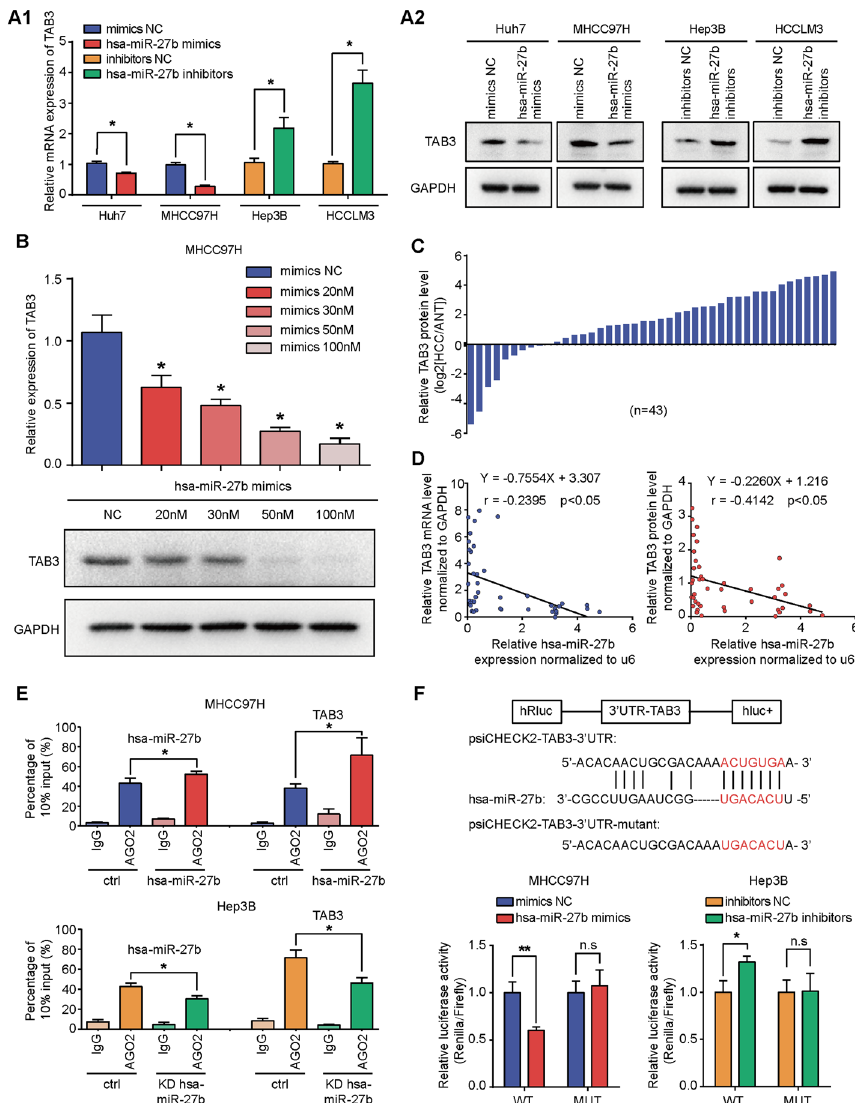
Fig. 4 TAB3 is the downstream target of hsa-miR-27b . A1 , A2 qRT-PCR ( A1 ) and western blot ( A2 ) analysis of TAB3 mRNA and protein levels after overexpression or knockdown of hsa-miR-27b in HCC cells. Data were normalized with GAPDH and are shown as the fold change relative to the control cells. GAPDH was used as a loading control for western blot analysis ( n 3 for qRT-PCR, Mann–Whitney test). B MHCC97H cells were = transfected with hsa-miR-27b mimics at the indicated concentrations. qRT-PCR analysis of TAB3 mRNA (top) and western blot analysis of TAB3 protein levels (bottom) were performed. Data were normalized to GAPDH and are shown as fold change compared with the cells treated with an NC for qRT-PCR ( n 3, one-way = ANOVA). GAPDH was used as a loading control for western blot analysis. C Relative TAB3 expression in HCC tissues ( n 43) compared with ANTs ( n 43) analysed by western blots. D Linear regression analysis between = = relative TAB3 mRNA (left) or protein levels (right) and hsa-miR-27b expression in HCC specimens ( n 43). = E RNA immunoprecipitation assays of 3 ′ UTR- TAB3 enrichments by anti-IgG or anti- AGO2 antibodies in the hsa-miR-27b -overexpressing MHCC97H cells (top) or the hsa-miR-27b -knockdown Hep3B cells (bottom). Data are shown as percentage of 10% input ( n 3, Kruskal–Wallis test). F Schematic diagram of hsa-miR-27b = binding sequences in the 3 ′ UTR of TAB3 and mutants in the 3 ′ UTR of TAB3 ( TAB3 -MUT) (top). Dual luciferase reporter assay of MHCC97H and Hep3B cells co-transfected with wild-type (WT) or mutated TAB3 3 ′ UTR luciferase reporter plasmids with hsa-miR-27b mimics or inhibitors ( n 3, Mann–Whitney test). A , B , E and = F were repeated three times. * p < 0.05. ** p < 0.01. Data are shown as mean SD. NC, negative control; ANT: ± adjacent non-tumourous tissues; HCC, hepatocellular carcinoma; 3 ′ UTR, 3 ′ untranslated region; ctrl, control; KD,